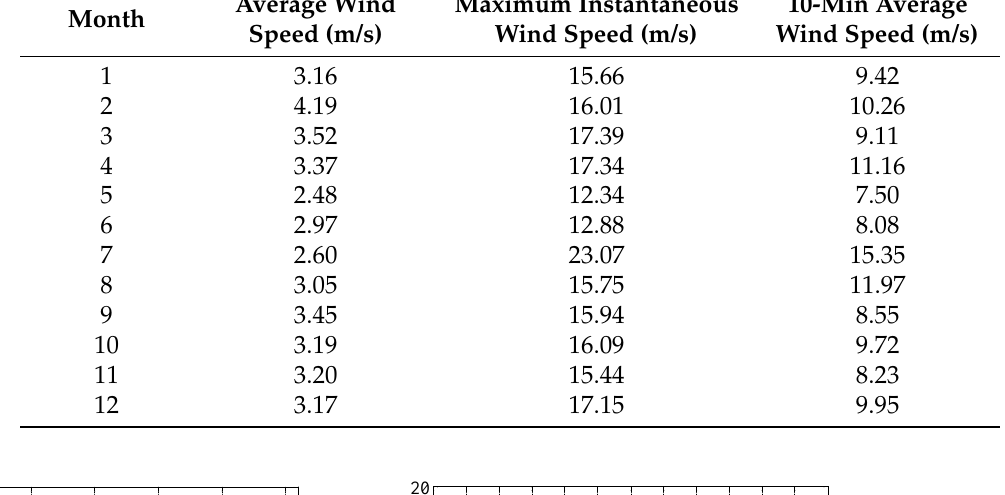
Figure 4. Variation tendency of the wind speed.